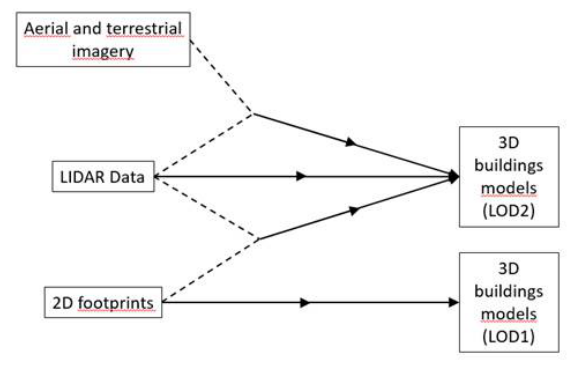
Figure 1. Established approaches for the creation of 3D building